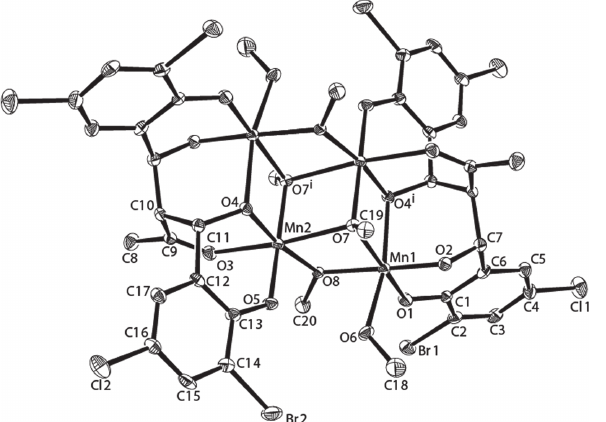
Table 1: Data collection and